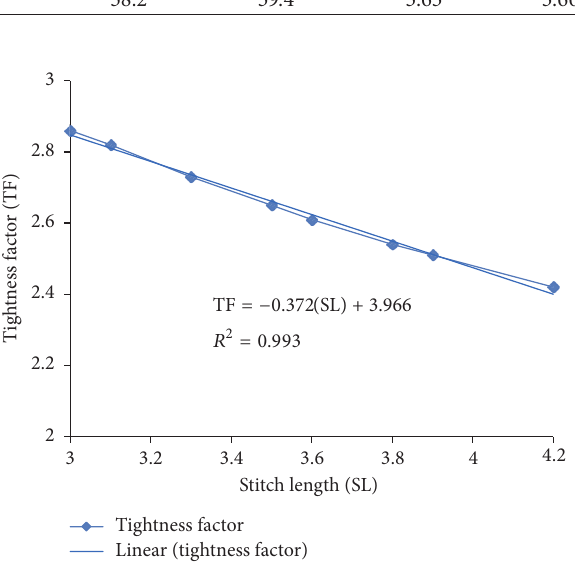
images)White mask images Linear (white mask images) Black mask images Linear (black mask Figure 11: % porosity against SL for CKM.